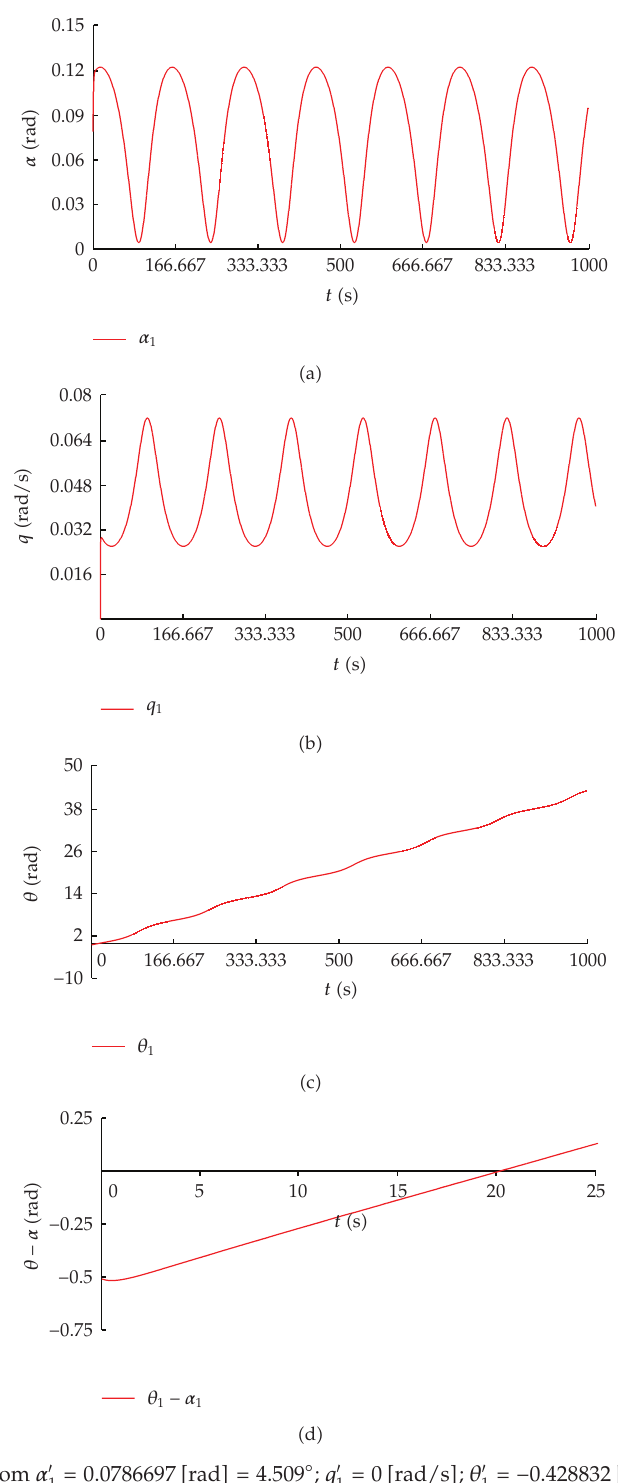
Figure 8: Transfer from α (cid:6) state which is appropriate for the touch-down moment: θ (cid:6)(cid:6) − α (cid:6)(cid:6) (cid:7) 0 and θ (cid:6)(cid:6) > 0 (cid:3) θ (cid:6)(cid:6) small (cid:4)